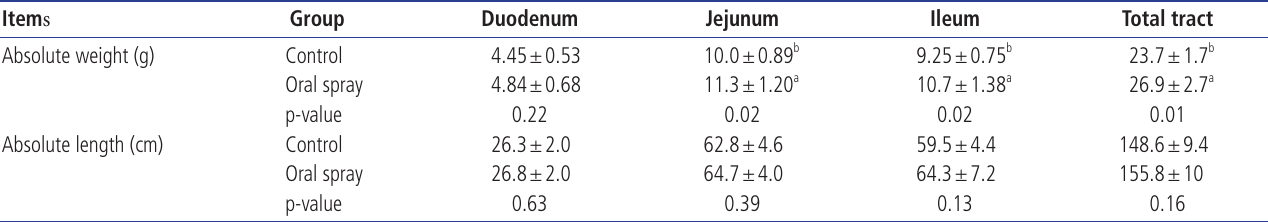
Table 5. Effect of oral spray with Lactobacillus on the absolute intestinal weight and length of ducklings at 21 d of age Item s